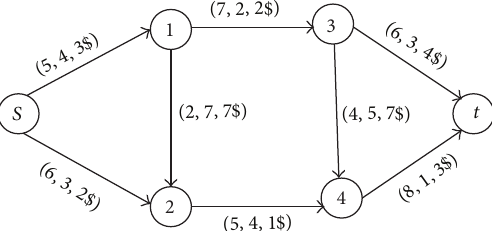
Figure 6: An example of the network flow; arc labels present as (𝑢 𝑖𝑗 , 𝑀 𝑖𝑗 ,𝑐 𝑖𝑗 )